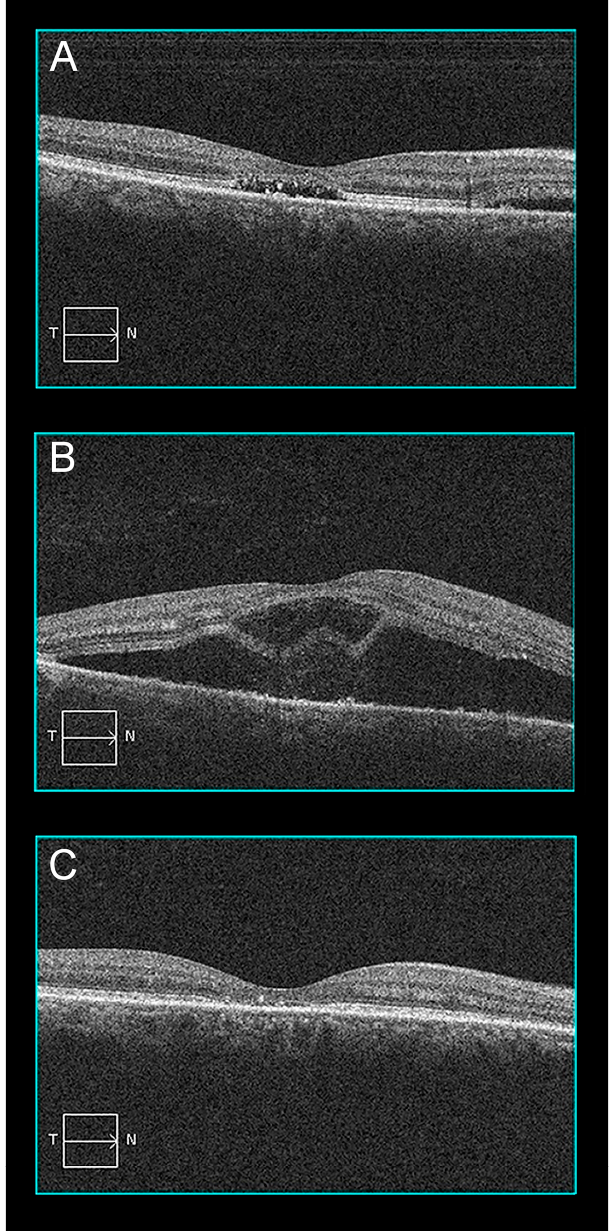
Figure 3. Patient 2 optical coherence tomography evolution before and after PDT: ( A ) Baseline OCT B-scan showing persistent subretinal fluid under the fovea and nasally; ( B ) two days after PDT, there was increased exudation with a bacillary layer detachment; ( C ) after 2 months, the exudation had reabsorbed completely but a small area of foveal thinning with ellipsoid and interdigitation zone disruption